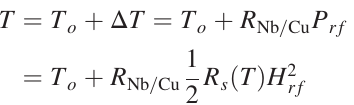
FIG. 5. Assumed step-like dependence for R s vs accelerating field E acc